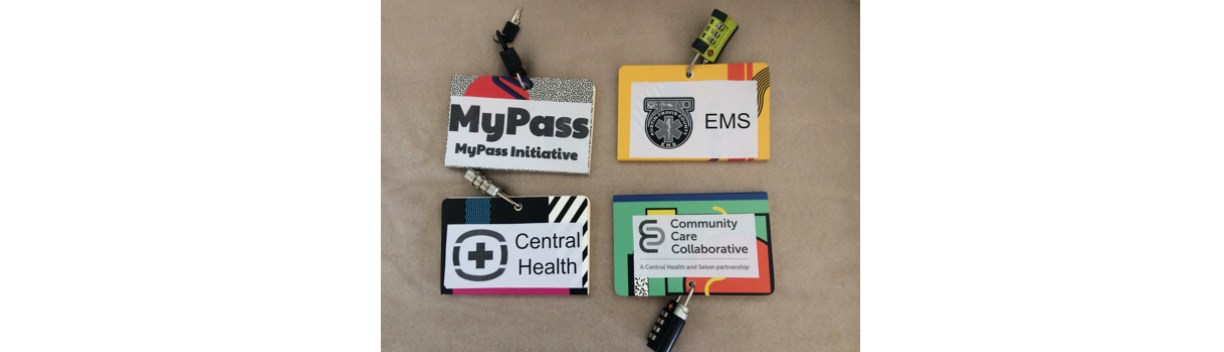
Figure 2. Distributed ledger technology